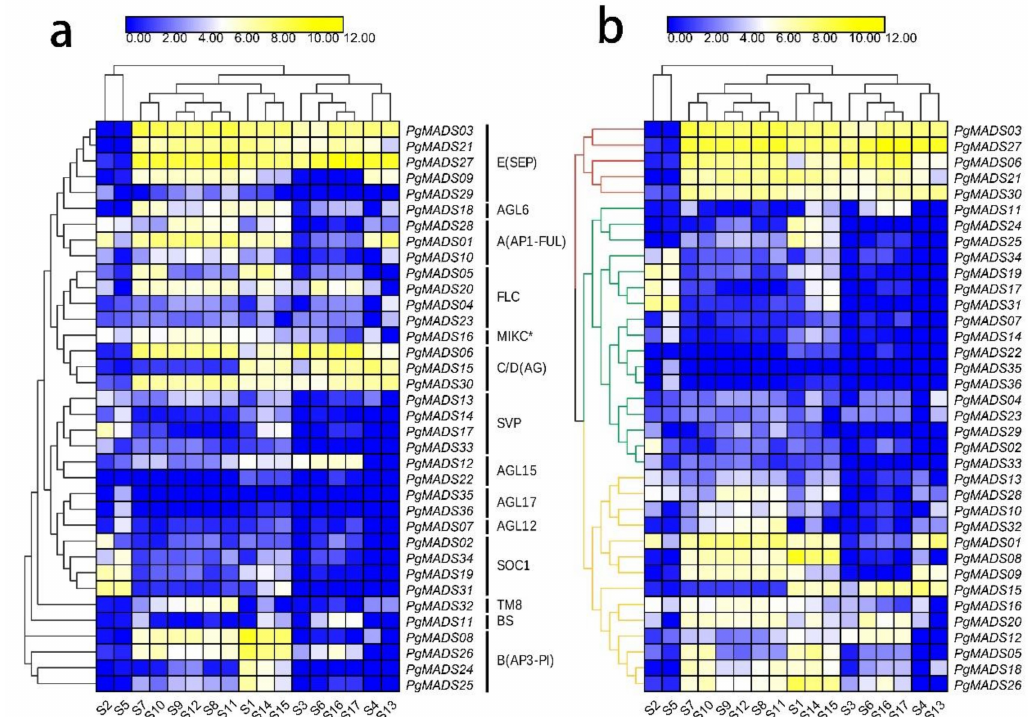
Figure 6. The heatmap of MIKC-type MADS-box family gene expression in di ff erent organs of pomegranate. Note: ( a ). Gene expression patterns of di ff erent subfamilies genes; ( b ). Hierarchical clustering of gene expression patterns. S1: flower; S2: leaf; S3: outer seed coat; S4: peel; S5: root; S6: inner seed coat; S7: functional male flower I; S8: functional male flower II; S9: functional